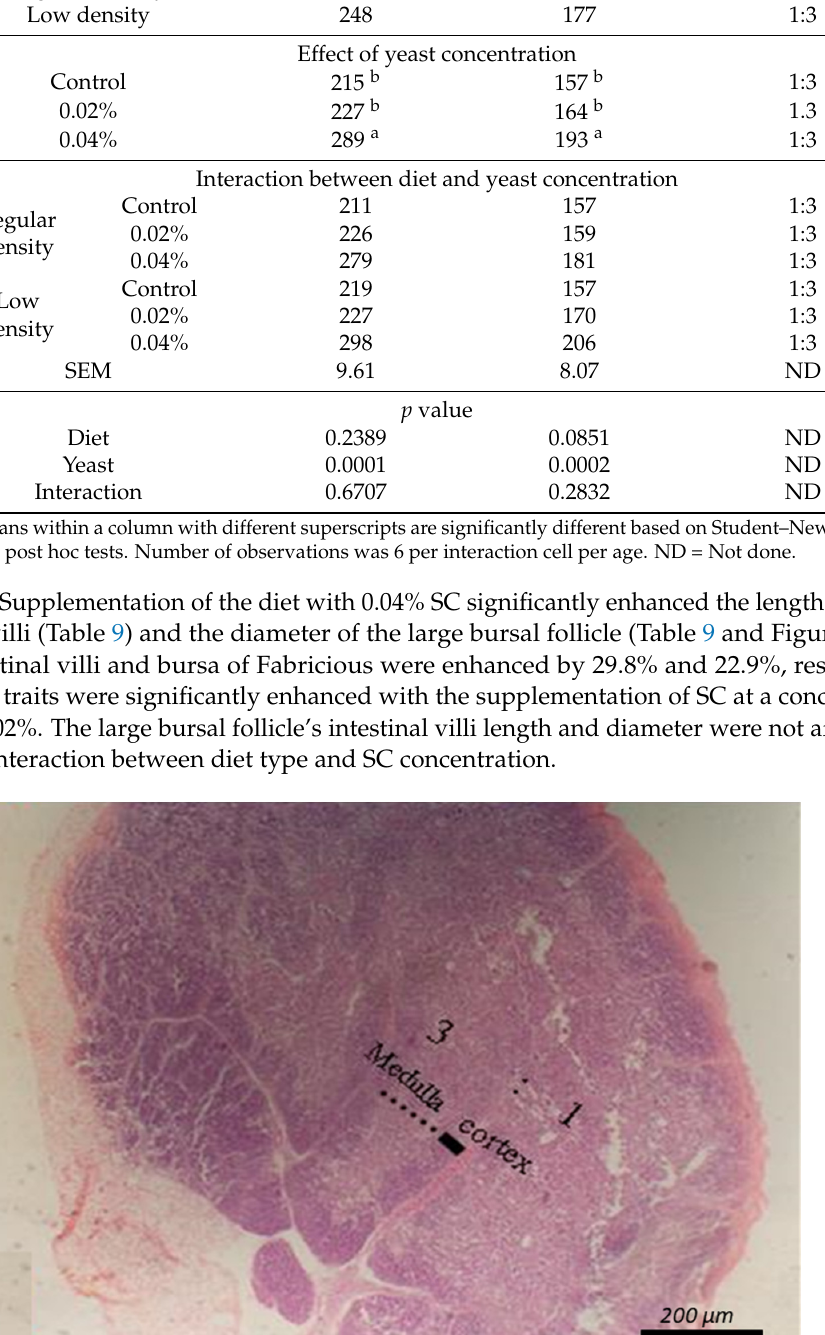
Figure 3. Micrograph of the spleen stained with HandE (X40) of regular density diet presented nor- mal splenic histology featuring splenic arteriole (thin arrow) with white and red pulp (thick arrow). All groups presented the normal splenic histology as the control. 4. Discussion The present work was conducted to fill the gap in knowledge regarding the impact of active SC yeast in relation to dietary composition on the antioxidant status, blood con- stituents and immune response of broiler chickens. Adding an SC product to the feed at concentrations of 0.02% or 0.04% improved the performance of broilers from 1 to 38 days of age. To our knowledge, this is the first study investigating the interactive relationship be- tween using yeast in low-density diets and its effect on immune response in broiler chick- ens. The percentage of thymus was significantly greater in birds fed a low-density diet than that of birds fed a regular-density diet. The immune response to NDV and AI were significantly greater in broilers fed a diet supplemented with 0.02% or 0.04% of SC than